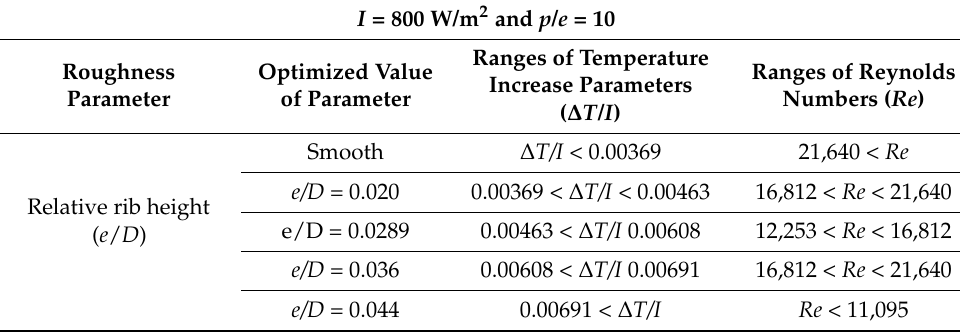
Figure 7. Effect of Reynolds number on effective efficiency.